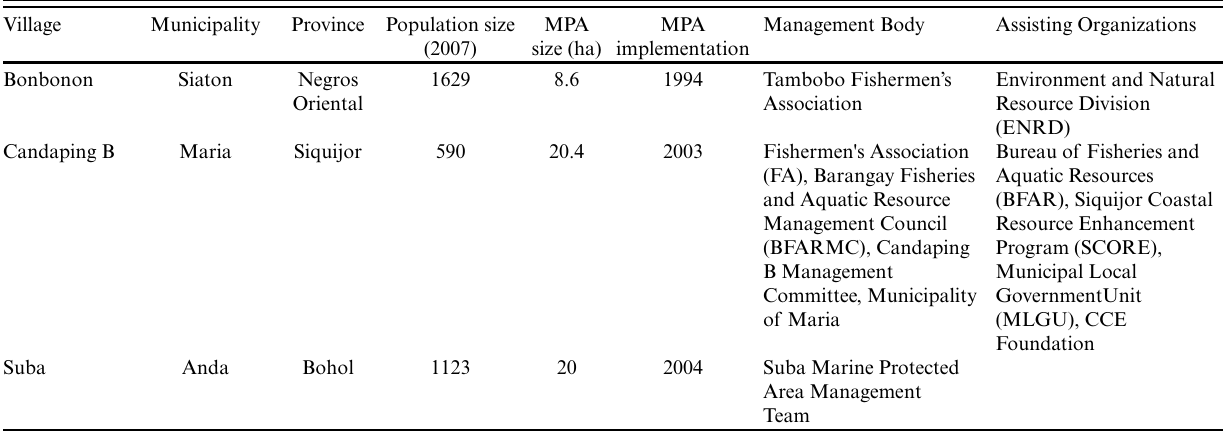
Table 1 . Characteristics of the three villages studied in the Visayas region of the Philippines.